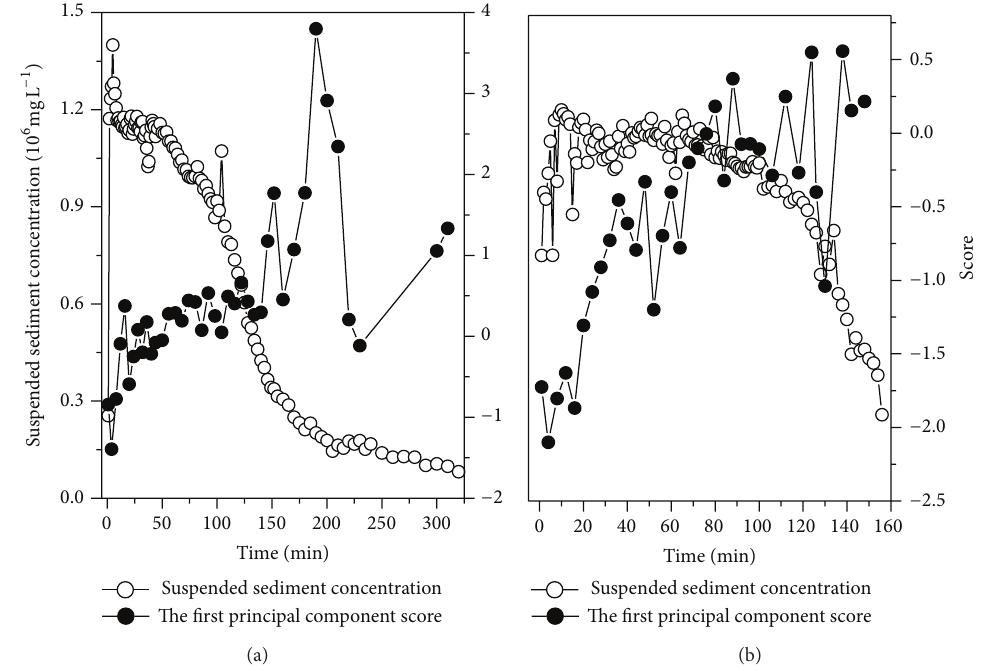
Figure 10: Temporal change in the first principal component score against the suspended sediment